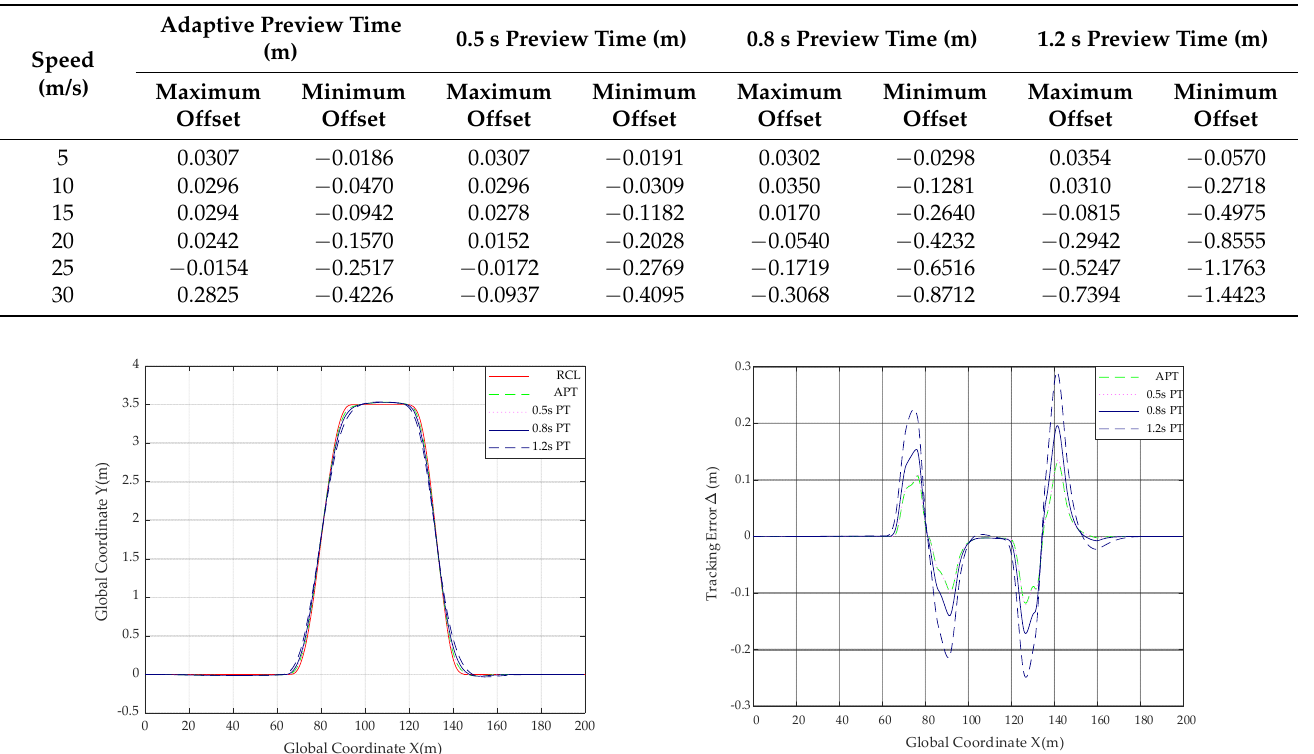
Table 5. Maximum and minimum offsets for different preview time and different speed for road segment three.